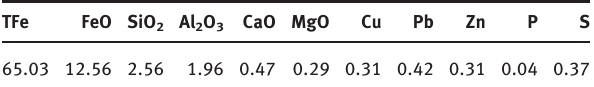
Table 1: Chemical composition of pyrite cinder (mass/%).